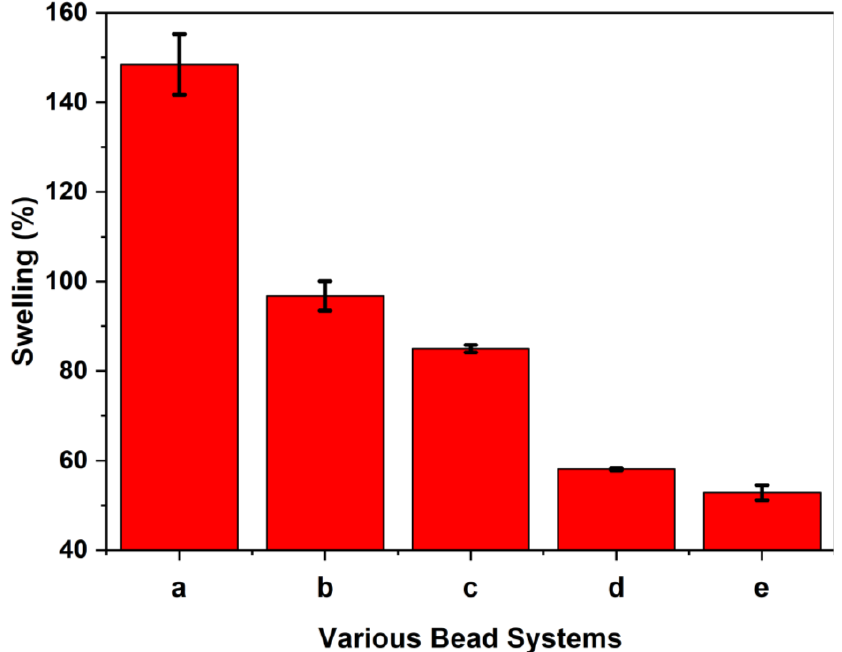
Figure 4. Swelling (%) for chitosan bead systems: non-modified beads (a), calcium imbibed beads with a CL- ratio of 1:10 (b), non-imbibed beads with a CL-ratio of 1:5 (c), calcium imbibed beads with a CL-ratio of 1:1 (d) and 5:1 (e).